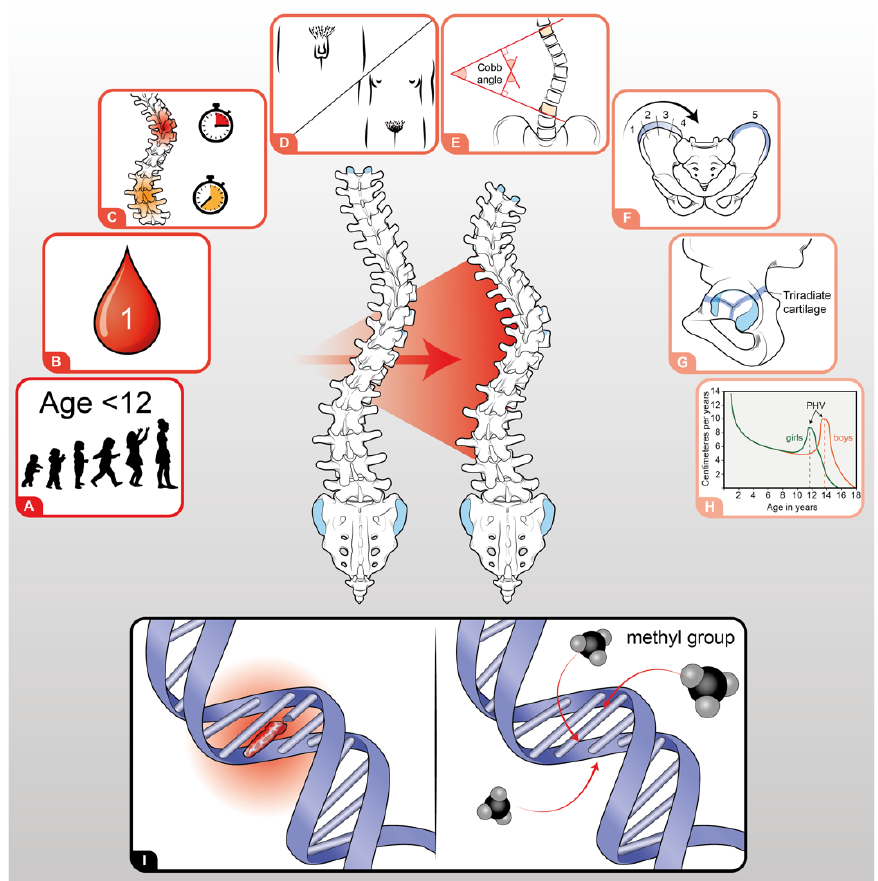
Figure 1. Parameters related to AIS ordered following their impact on scoliosis progression: ( A ) Age <12 years; ( B ) premenarche status; ( C ) localization of the main curve; ( D ) Tanner stage; ( E ) main curve Cobb angle at diagnosis; ( F ) Risser Stage; ( G ) status of triradiate cartilage; ( H ) high peak velocity; ( I ) genetic (left) and epigenetic (right) factors.